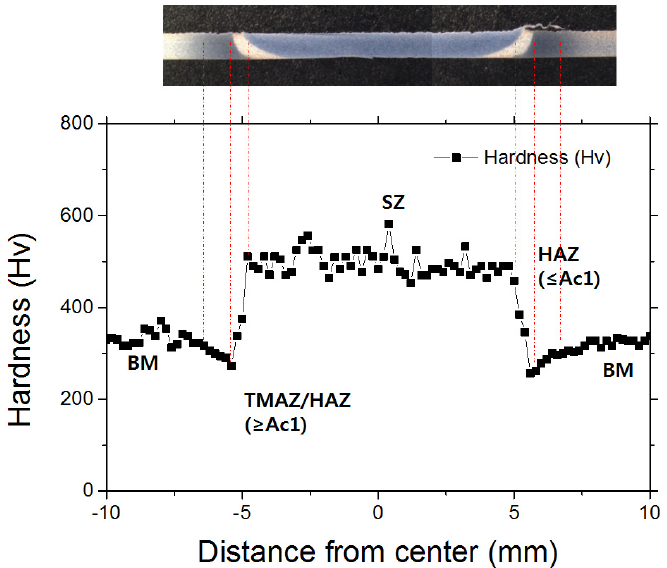
Figure 5. Hardness profile on the DP980 FSW joints.